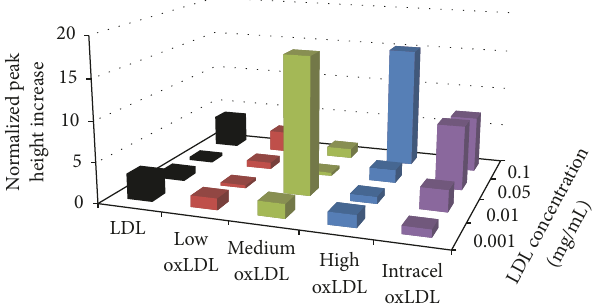
Figure1:AveragemetabolicglucoseconsumptionresponseofRAW 264.7 cells to a 6min exposure of various LDL. Percent increases were calculated based on the variation from the maximum peak height chance during exposure to the baseline average, prior to exposure. For native LDL, the glucose consumption at 100 𝜇 g/mL the number of averaged experiments ( 𝑛 ) is 4 and the standard error of the mean for the basal metabolic rate of the baseline is ± 0.20%. For 50 𝜇 g/mL 𝑛 = 2 ; ± 0.27%, 10 𝜇 g/mL 𝑛 = 2 ; ± 0.01%, and 1 𝜇 g/mL 𝑛 = 4 ; ± 6.1%. For low oxLDL, 100 𝜇 g/mL 𝑛 = 3 ; ± 12.5%, 50 𝜇 g/mL 𝑛 = 5 ; ± 3.4%, 10 𝜇 g/mL 𝑛 = 3 ; ± 0.36%, and 1 𝜇 g/mL 𝑛 = 2 ; ± 0.38%. For medium oxLDL at 100 𝜇 g/mL 𝑛 = 2 ; ± 0.33%, 50 𝜇 g/mL 𝑛 = 3 ; ± 0.51%, 10 𝜇 g/mL 𝑛 = 4 ; ± 0.16%, and 1 𝜇 g/mL 𝑛 = 5 ; ± 0.32%. For high oxLDL at 100 𝜇 g/mL 𝑛 = 3 ; ± 0.5%, 50 𝜇 g/mL 𝑛 = 3 ; ± 9.7%, 10 𝜇 g/mL 𝑛 = 3 ; ± 0.44%, and 1 𝜇 g/mL 𝑛 = 3 ; ± 8.6%. For Intracel oxLDL at 100 𝜇 g/mL 𝑛 = 4 ; ± 1.8%, 50 𝜇 g/mL 𝑛 = 6 ; ± 15.4%,